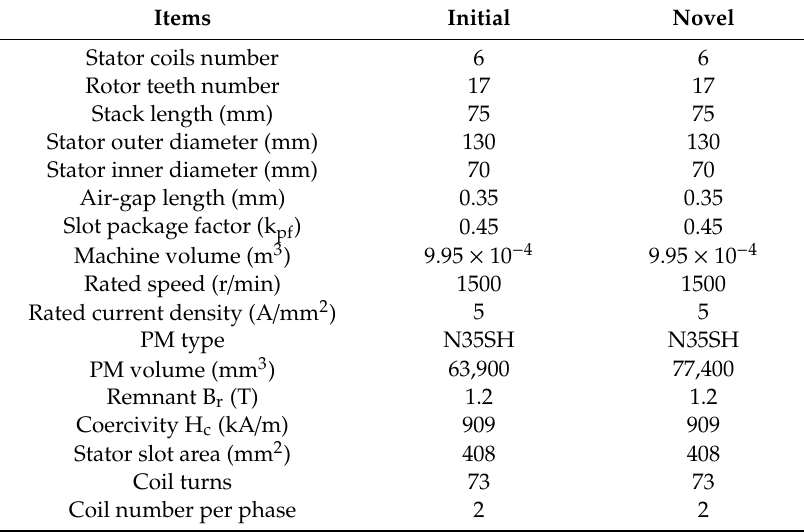
Table 1. Design parameters of two FSPM machines.